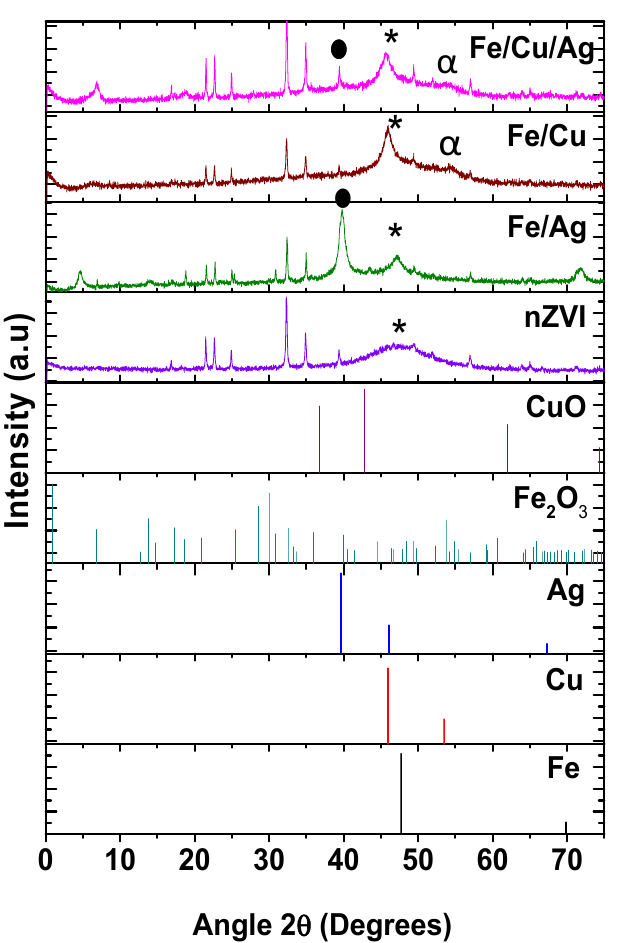
Figure 1. XRD patterns of nZVI, Fe/Ag (5:0.1), Fe/Cu (5:1) and Fe/Cu/Ag (5:1:0.2) nanoparticles and the relevant standard reference patterns. ( * Peaks of Fe 0 , α Peaks of metallic Cu and ● Peaks of metallic Ag).